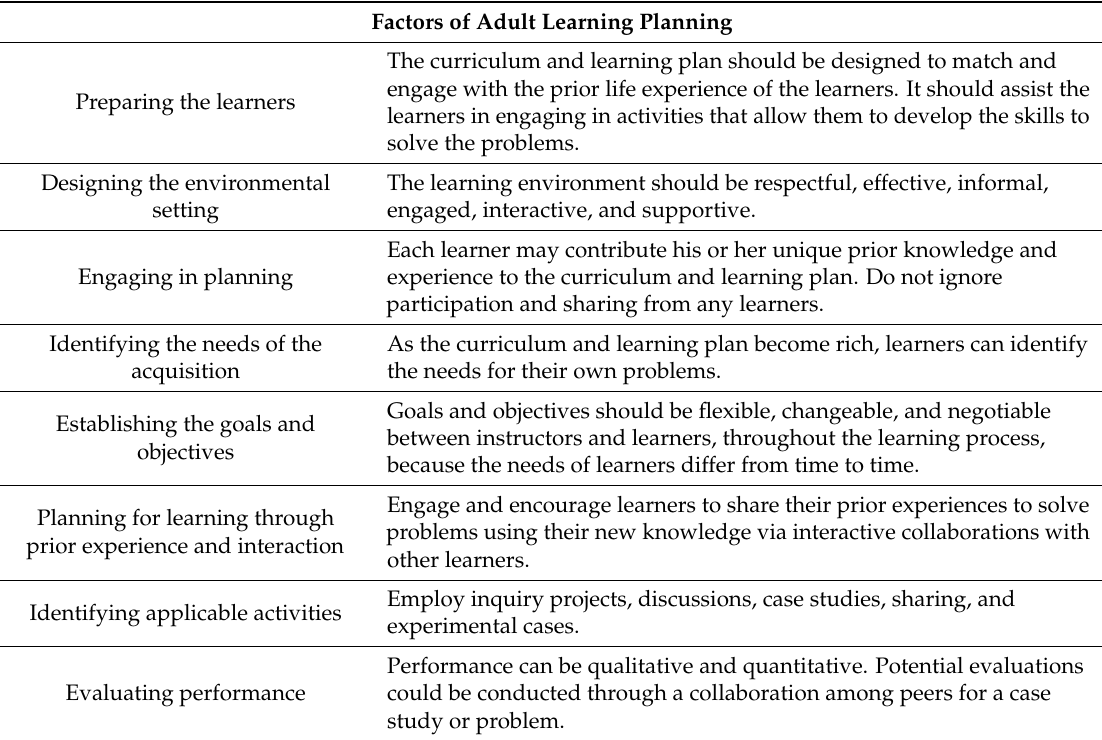
Table 1. Factors of adult learning